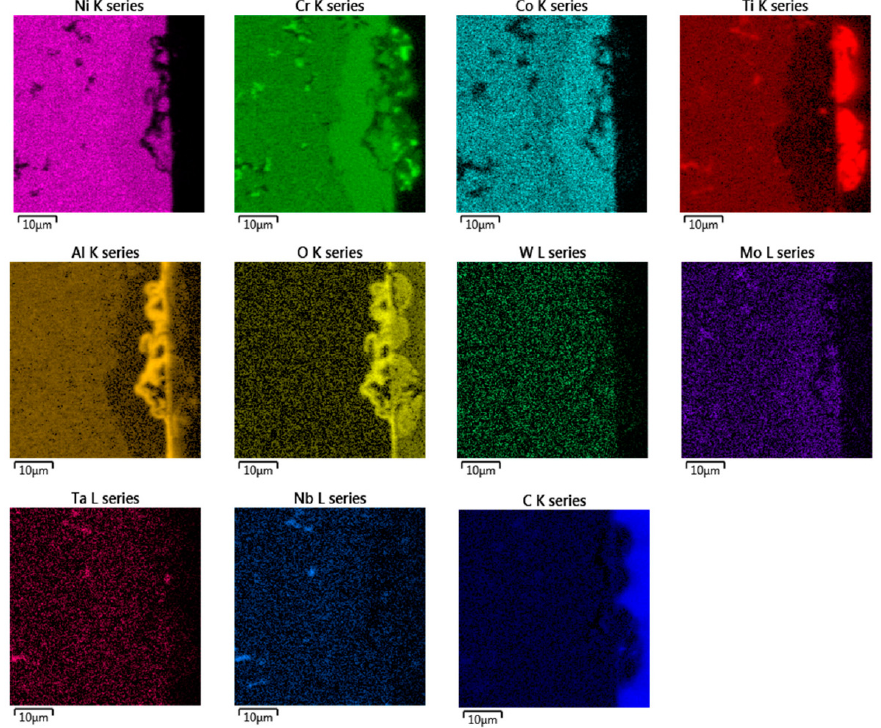
Figure 5. EDX chemical mapping of IN738—50R after exposure to He.